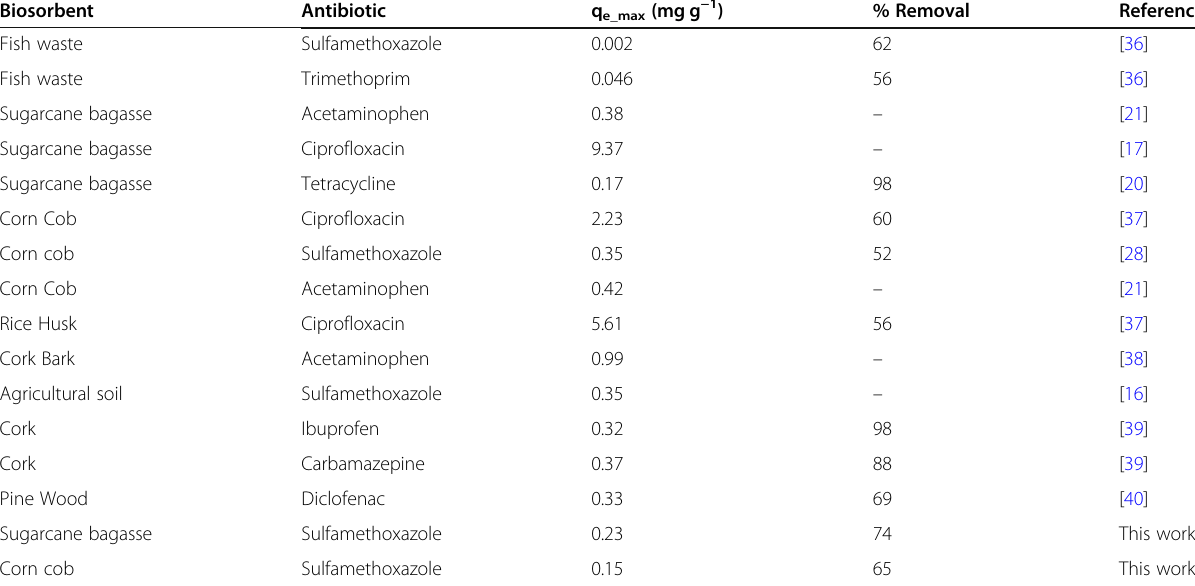
Table 7 Comparison of adsorption properties with other biosorbents